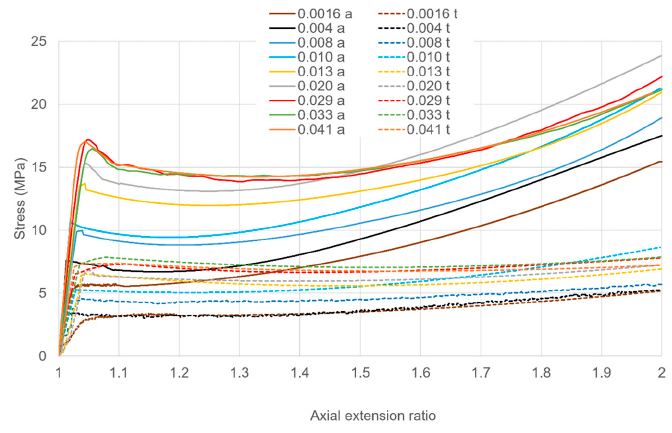
Figure 5. Stress-strain curves during loading for axial (full line, a) and transverse (broken line, t) stresses. They key shows octahedral strain rates in s − 1 . Times of loading range from 19.9 s at 0.041 s − 1 to 510 s at 0.0016 s − 1 .